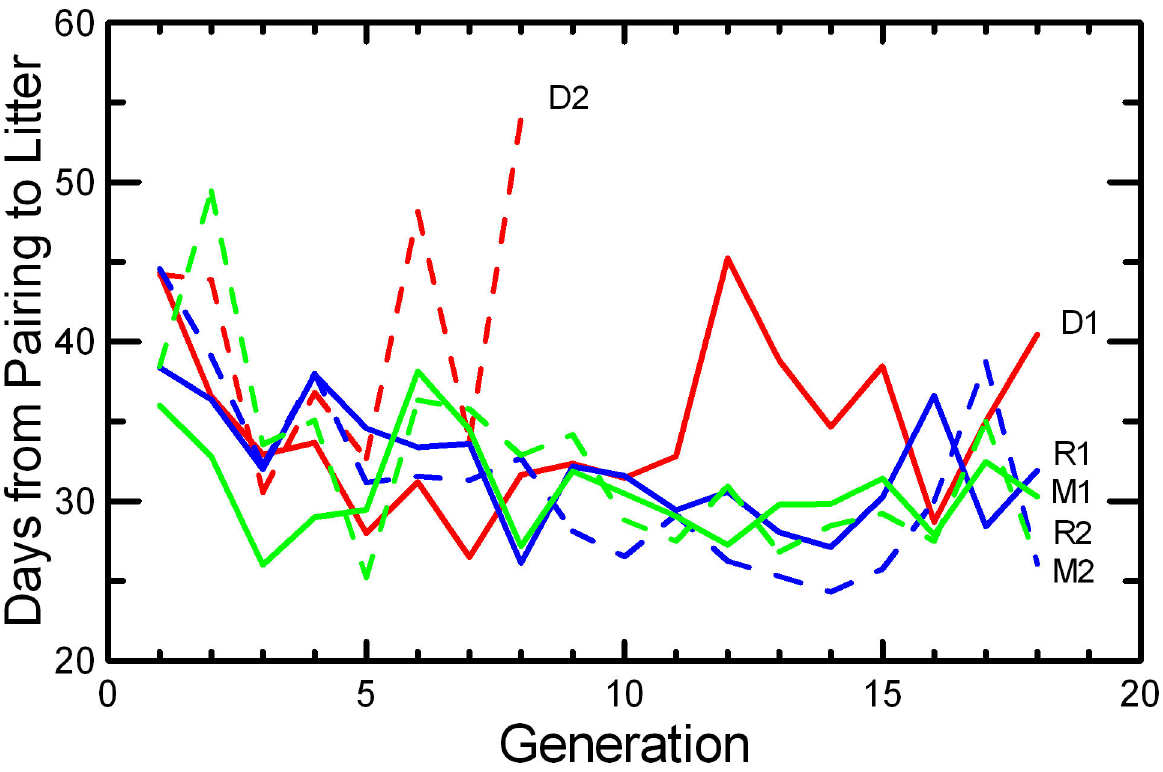
Figure 6. Delay between pairing and litter birth. The mean time (d) between pairing and the birth of a litter for those pairs that produced at least one litter is given for the two replicates of RAN (blue), MK (green), and DOC (red) experimental populations. Note that the y-axis starts at 20 d, a few days shorter than the typical gestation